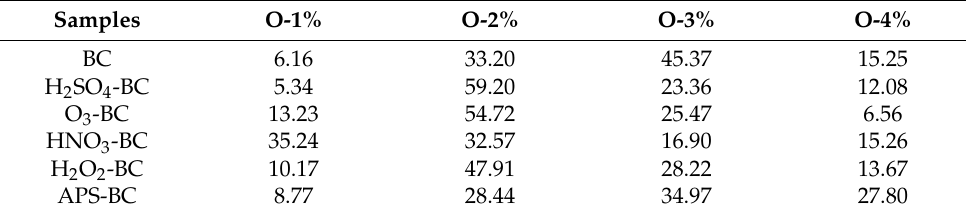
Table 6. Relative contents of O1s peaks in biochar samples obtained by XPS